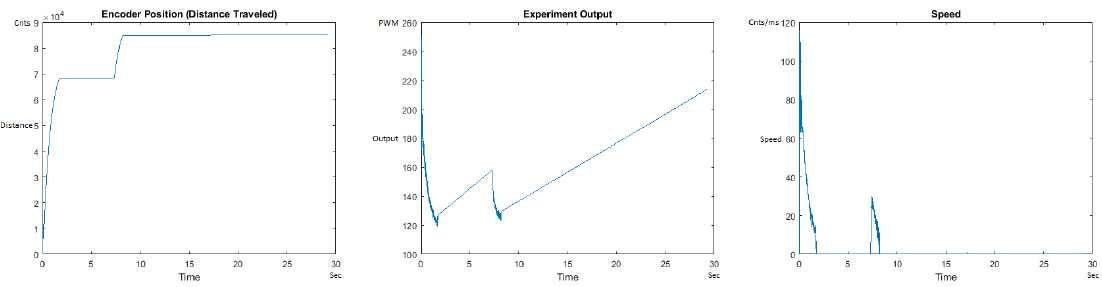
Figure 36. Encoder position, output and speed plots for basic PID UP Operation—1